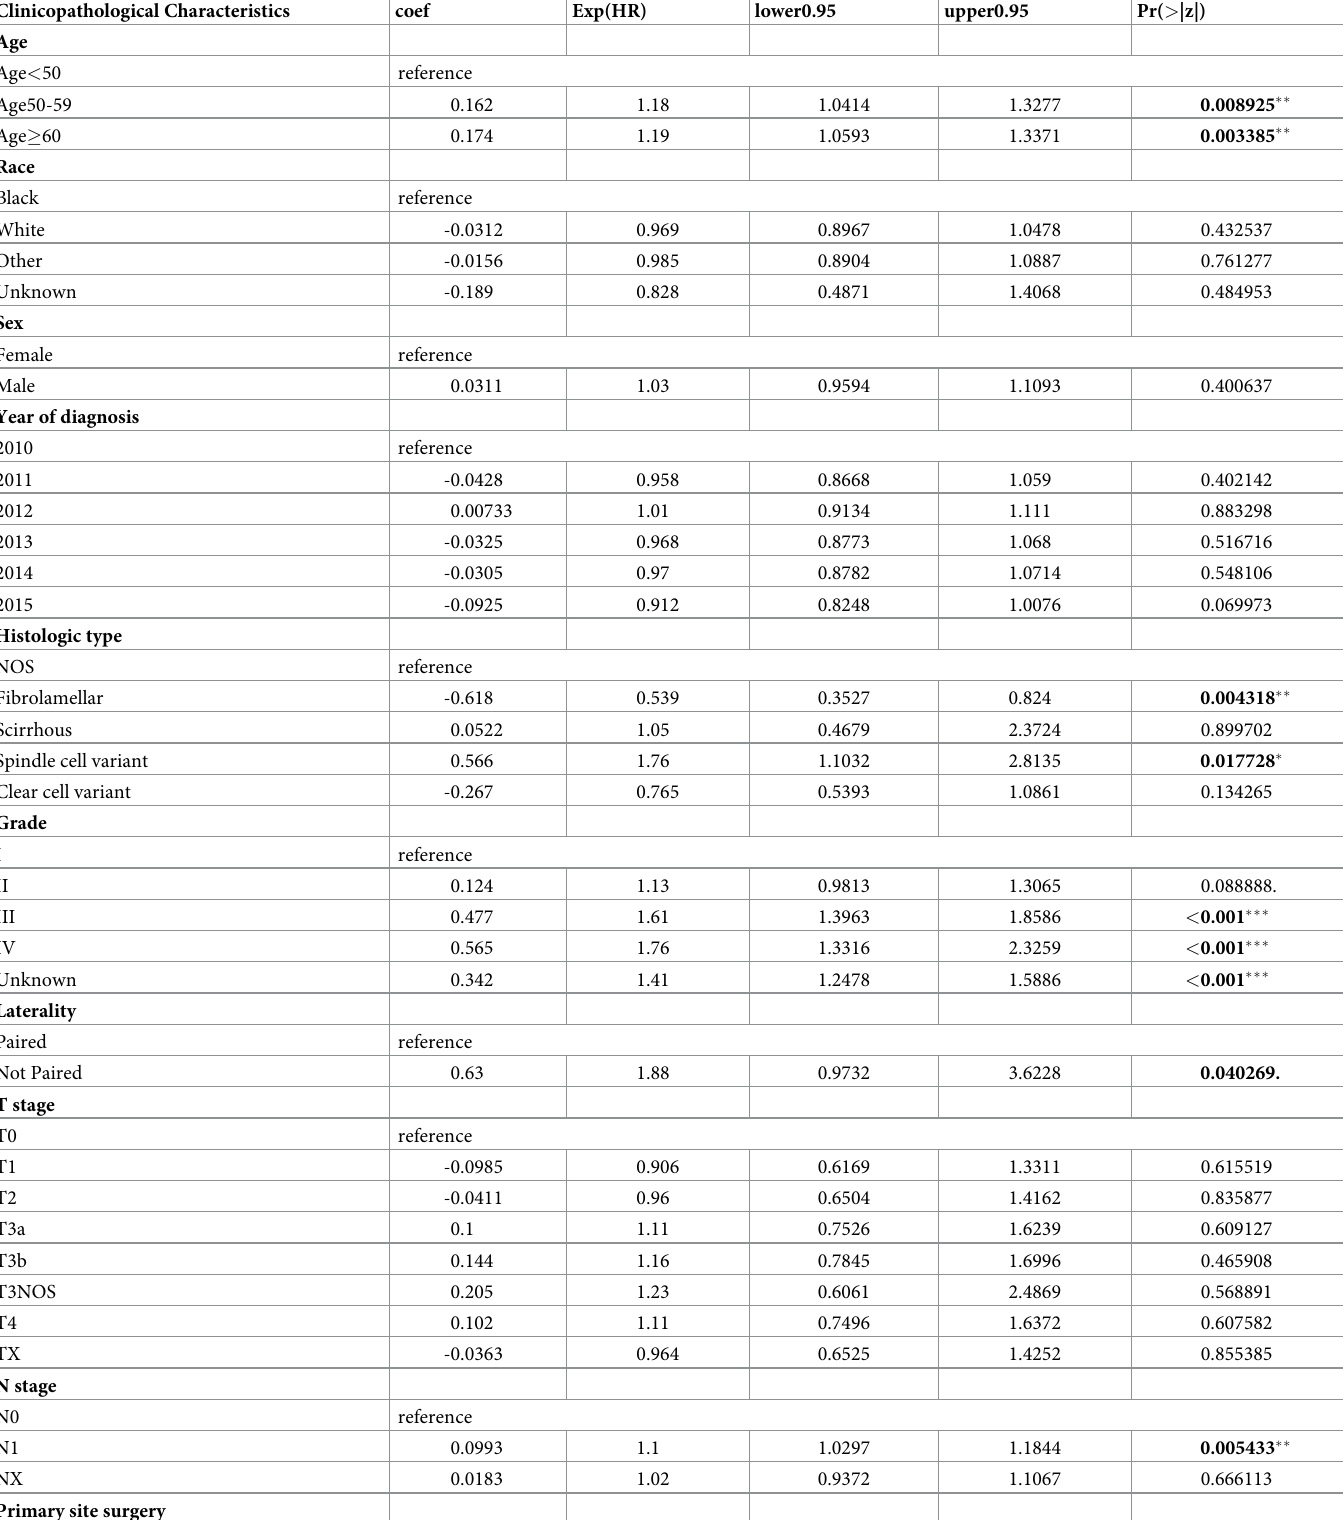
Table 5. Multivariate-Cox regression analysis of the cohort